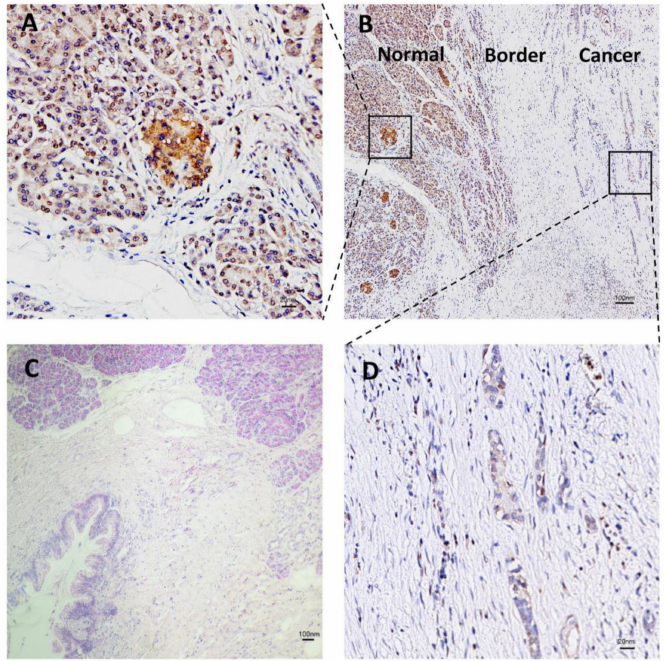
Figure 3. Immunohistochemistry (IHC) staining tissues of NRDC in pancreatic ductal adenocarci- noma. ( A ) Expression of NRDC protein in human pancreatic normal tissue ( n = 6). ( B ) The overview of IHC in cancer and normal tissue. ( C ) H&E staining of human pancreatic ductal adenocarcinoma and normal tissue. ( D ) Expression of NRDC protein in human pancreatic ductal adenocarcinoma tissue ( n =